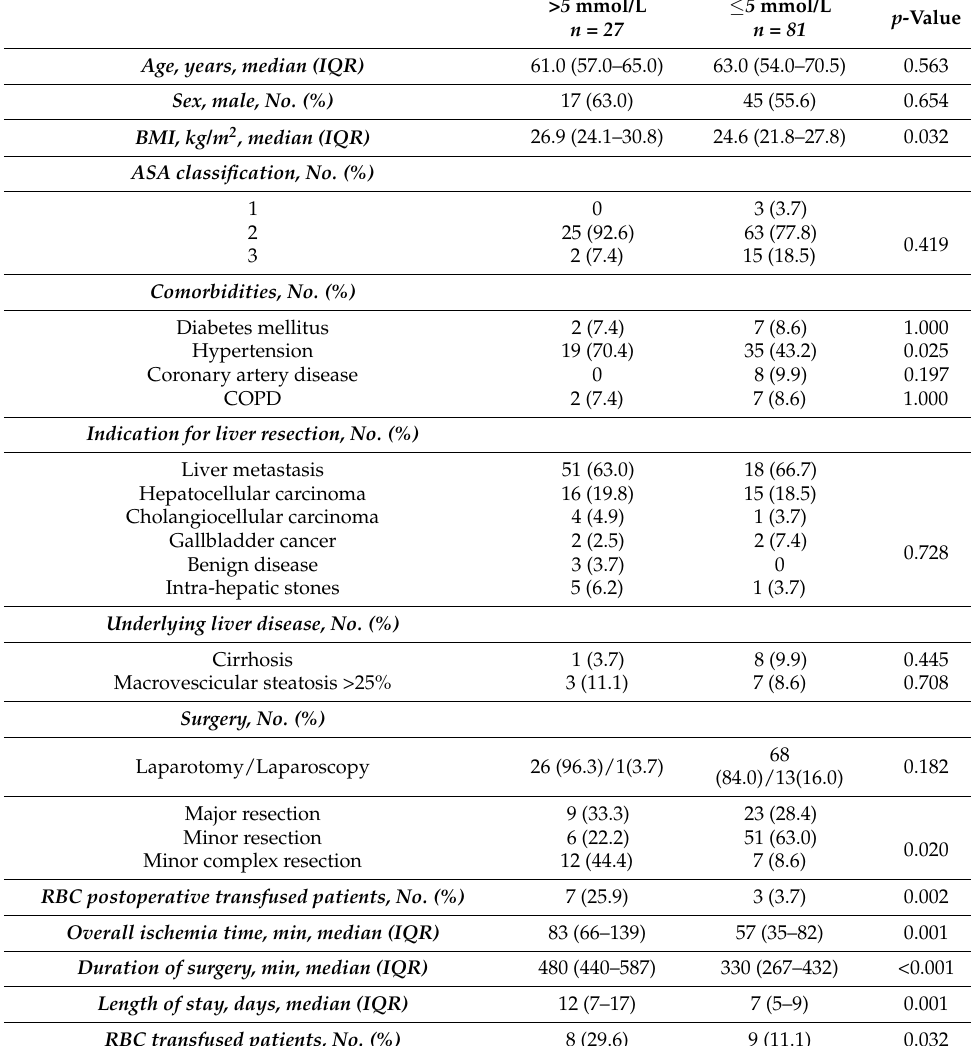
Table 3. Demographics and clinical characteristics according to end-surgery arterial lactate